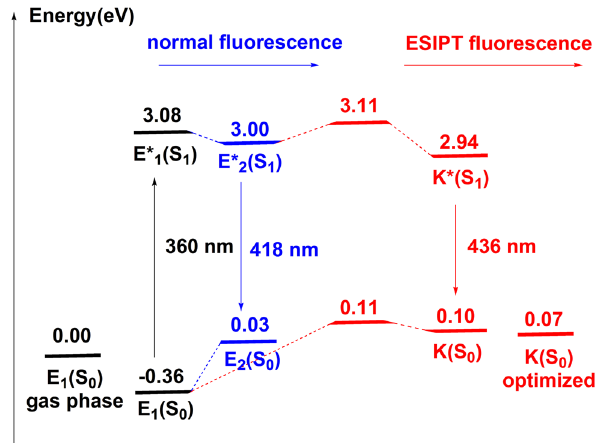
Figure 1: The energy pro fi le of the fl uorescence in the HNLSC with the cyclohexane solvation.